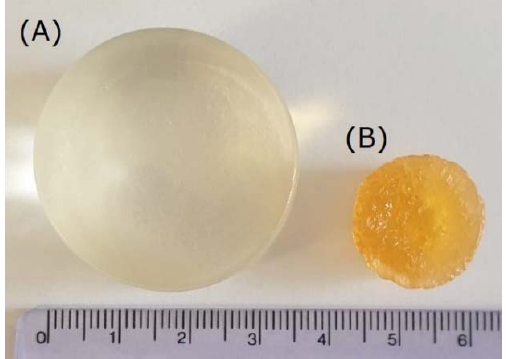
Figure 4. Visual representation of the exemplary gelatin/PVA-based hydrogel material tested in the current study. The material in the hydrated state ( A ) and after drying to a constant weight ( B ). In turn, the differences in the content of the water phase between the cross-linked structure of each tested hydrogel are presented in Table 3. Table 3. Water content in gelatin and gelatin/PVA hydrogels. Table 3. Water content in gelatin and gelatin/PVA hydrogels.